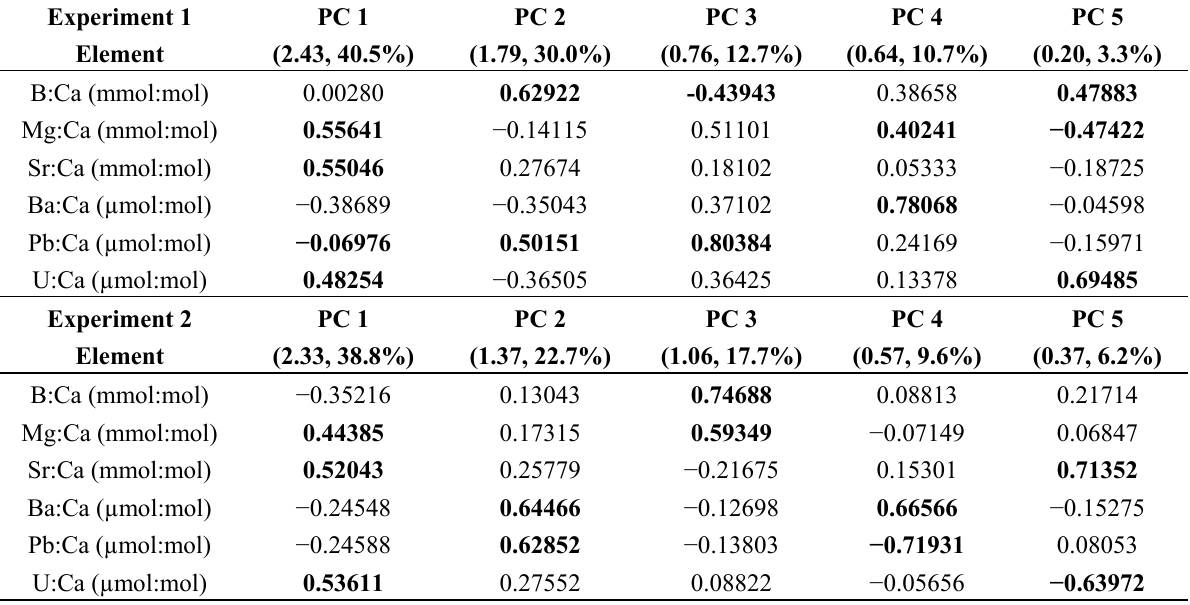
Table 4. Elements driving compositional differences among treatments (correlation matrix; elemental menu = B:Ca, Mg:Ca, Sr:Ca, Ba:Ca, Pb:Ca, U:Ca). Eigenvalues and the percentage of variance explained are listed beneath each principle component